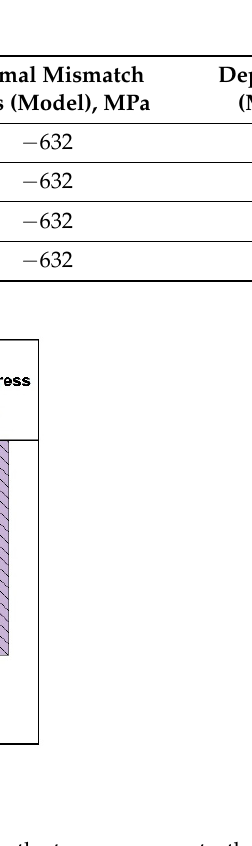
Figure 13. Decomposition of the total residual stress into the two components, the thermal mismatch stress and the deposition stress, for the coatings with different WC grain